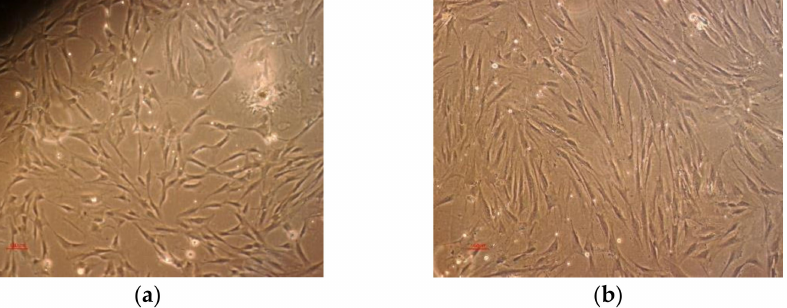
Figure 4. Optical microscopy (scale bar: 100 µ m) images of: ( a ) Osteoblasts precursors at 10 days of incubation and ( b ) Osteoblasts after first